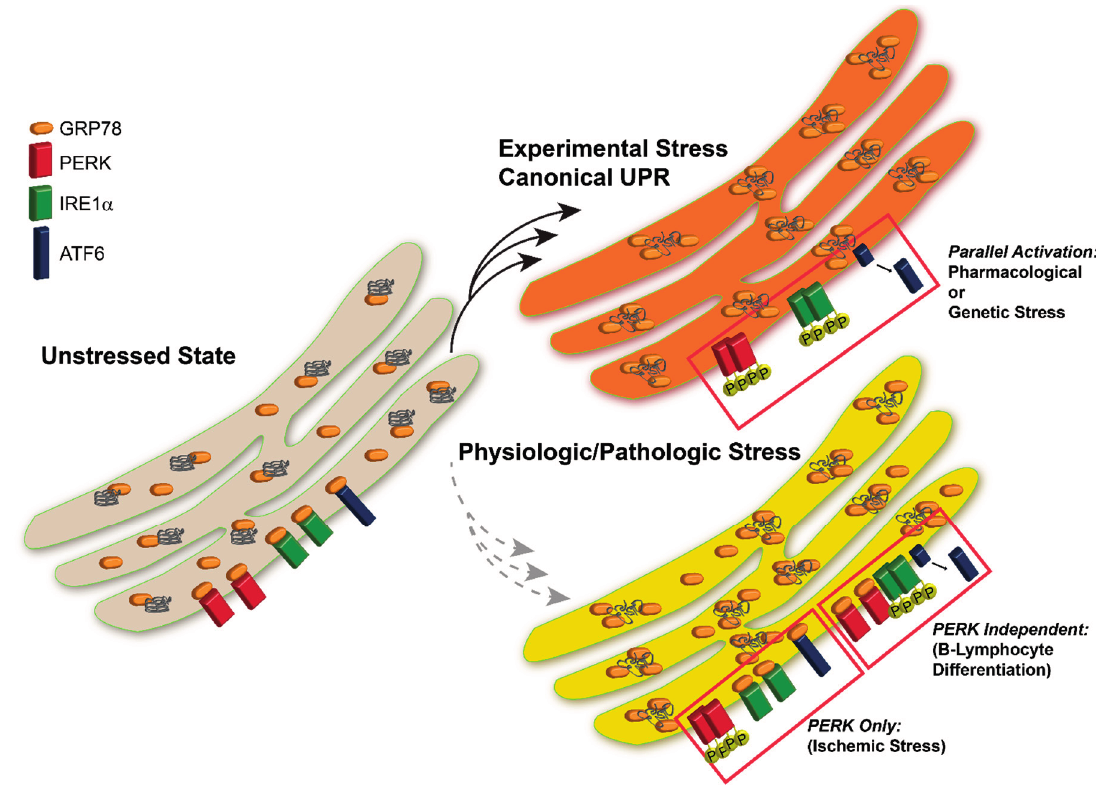
Figure 1. UPR Activation in Following Experimental vs. Pathological Stress. Induction of the UPR with pharmacologic agents results in parallel activation of all three UPR sensor proteins. Physiologic or pathological stresses often induce activation of specific components of the UPR, however all sensors are not activated uniformly following all